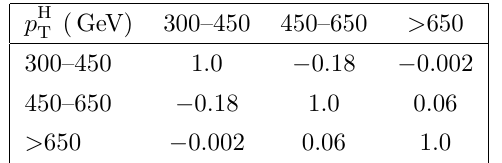
bins of the unfolded ggH differential cross T